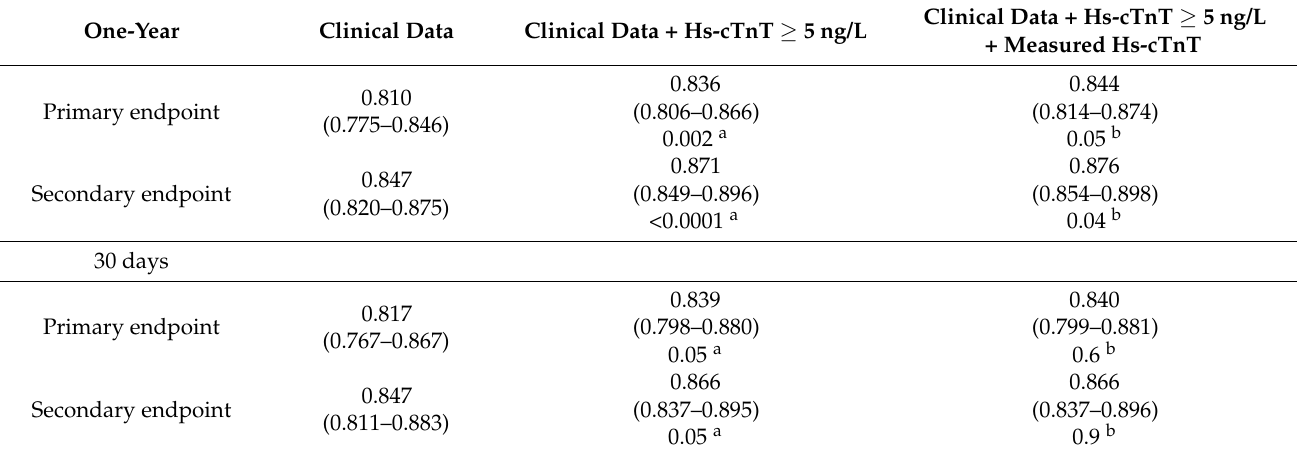
Table 3. Discrimination accuracy (area under the receiver operating characteristic curve) of the predictive models for the pri- mary (death or acute myocardial infarction) and secondary (death or acute myocardial infarction or urgent revascularization) endpoints.